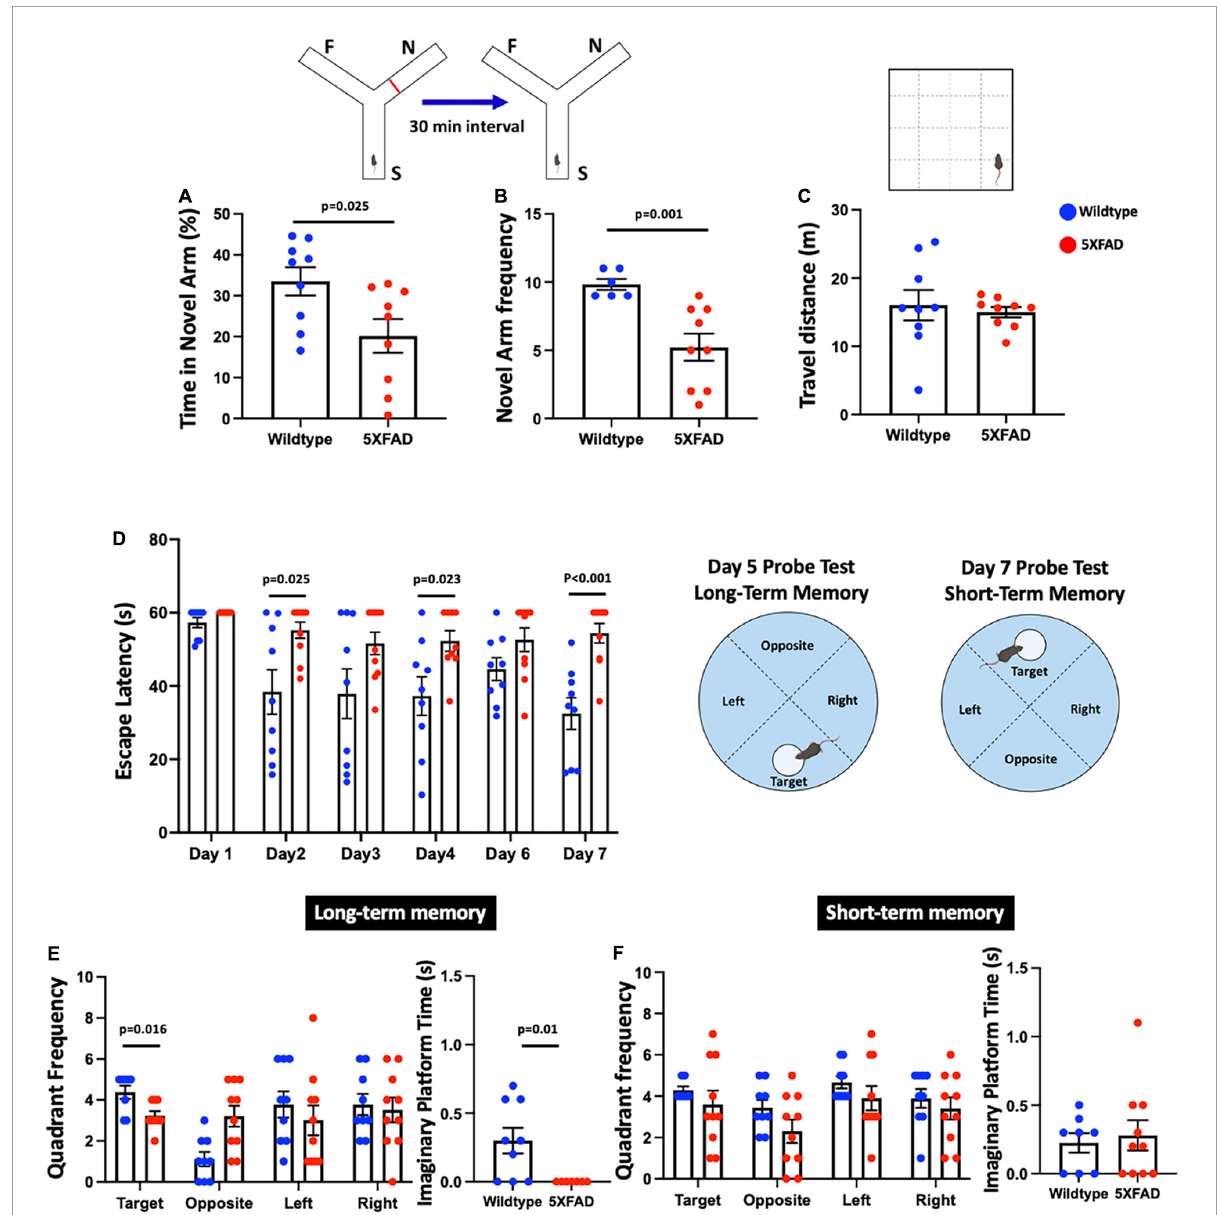
FIGURE1 A symmetrical Y-maze experiment was conducted with Start Arm (S), Familiar Arm (F), Novel Arm (N). 5xFAD mice showed (A) significantly decreased proportion of time spent (%) in the novel arm, (B) significantly decreased frequency of visits to the novel arm, (C) no significant difference in the distance traveled compared to wildtype mice, (D) significantly increased escape latency (s) on days 2, 4, and 7, but no significant differences on days 1, 3, and 6, (E) significant decreased frequency to enter the target quadrant and time spent on the platform in the long-term memory probe test, and (F) no significant difference in the short-term memory probe test.